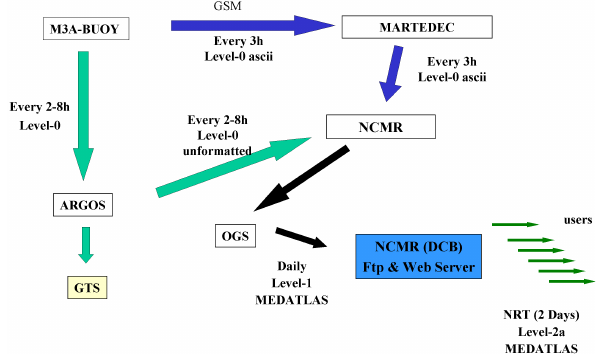
Fig. 3. External data flow of the M3A